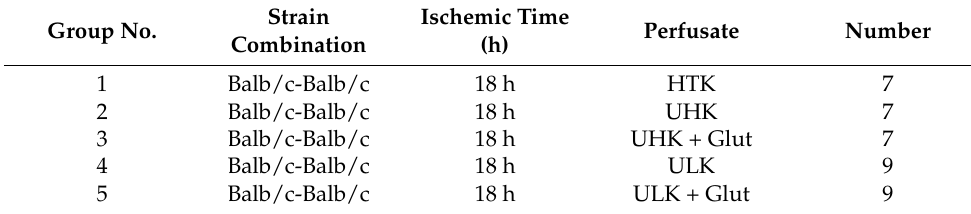
Table 2. Experimental